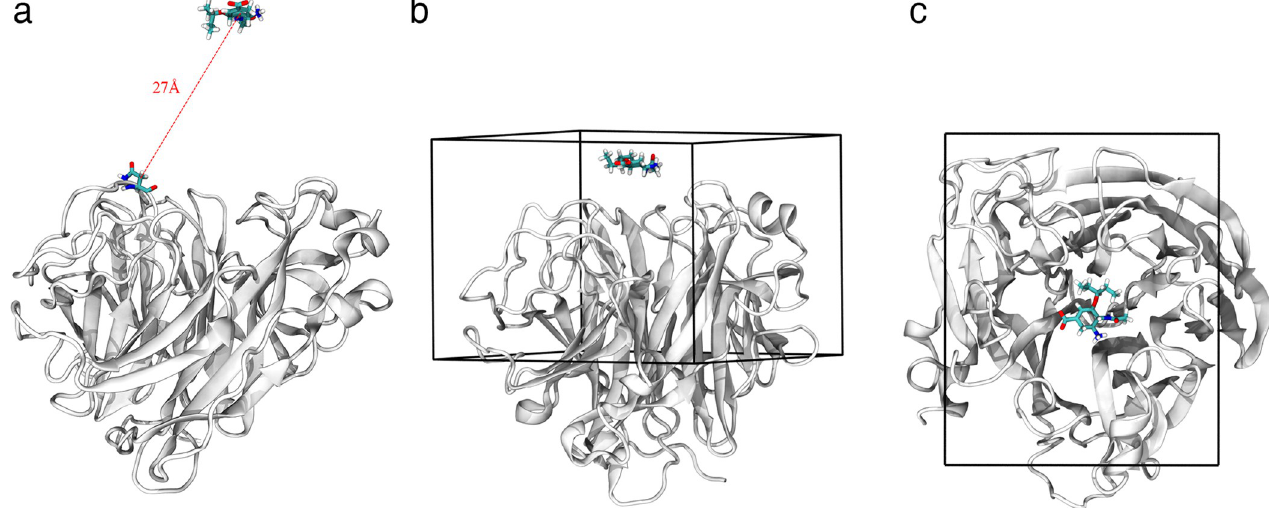
Fig 1. Sampling space for oseltamivir in the simulations. (a) The diffusion region of oseltamivir in the free-binding MD simulation; oseltamivir was restricted in a space centered on the beta carbon of N346 with a radius of 27 Å . (b) and (c) Side and top views of the sampling region (cuboid box with a size of 46 Å× 38 Å× 32 Å ) for the meta-eABF simulation.